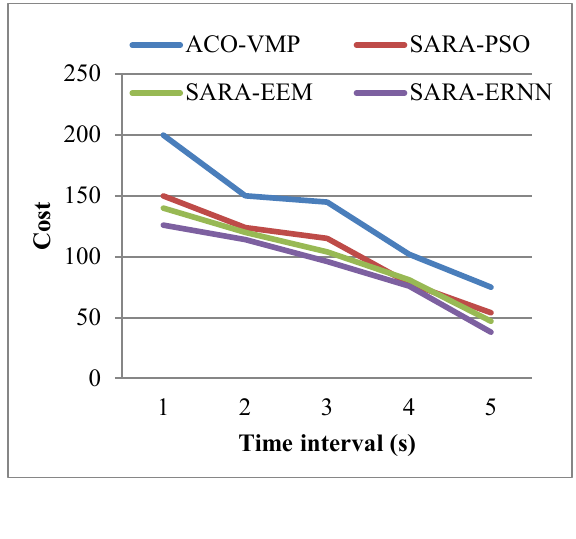
Figure 7. Cost efficiency of the novel and the available resource allocation methods